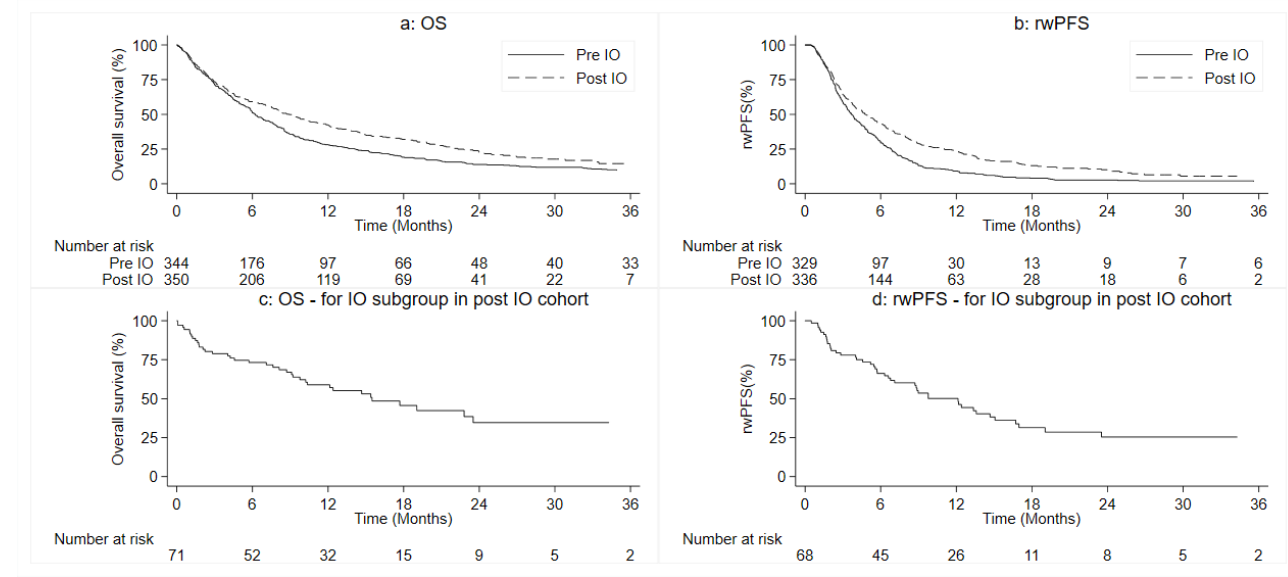
Figure 3. Estimation of probability of ( a ) OS and ( b ) rwPFS in 1L through Kaplan - Meier curves in the entire Pre-1L and Post-1L IO cohorts, respectively. Figures represent ( c ) OS and ( d ) rwPFS asso- ciated with the Post-1L IO subgroup with ICI as a first-line treatment.